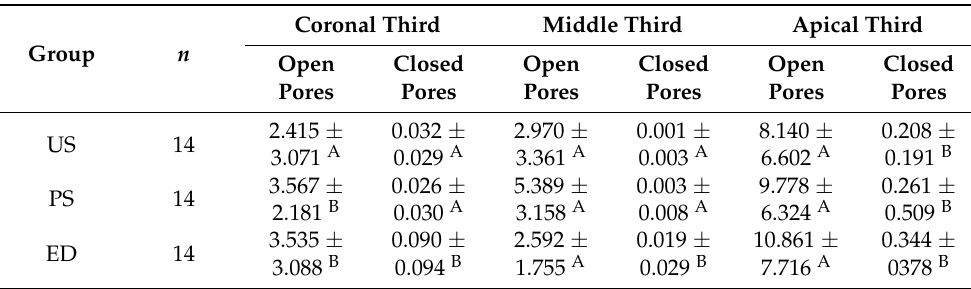
Table 1. Mean values (%) and standard deviations (SD) of open and closed pores in the coronal, middle and apical thirds. Coronal Third Middle Third Apical Third Group n Open Pores Closed Pores Open Pores Closed Pores Open Pores Closed Pores US 14 2.415 ± 3.071 A PS 14 3.567 ± 2.181 B 14 Groups marked with the same superscript letter in the same column do not differ significantly (pairwise Mann–Whitney test; p > 0.05).